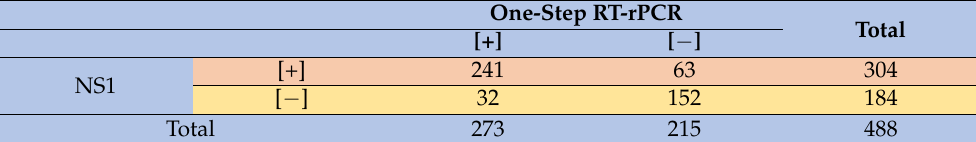
Table 1. Results of qPCR assay and NS1 tests in the overall 488 participants.